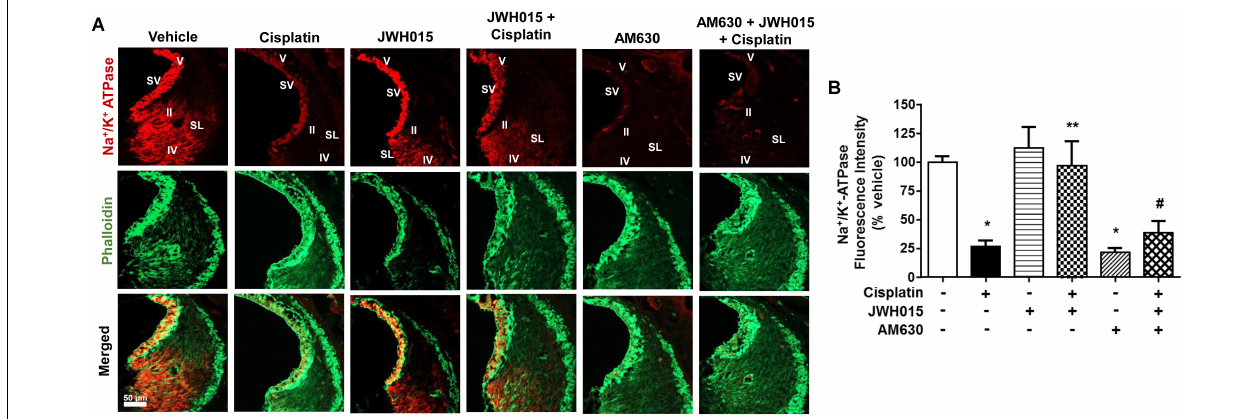
FIGURE 6 | Activation of CB2R by JWH015 mitigates cisplatin-induced loss of Na + /K + -ATPase- α 1 levels in the rat cochlea. (A) Mid-modiolar sections of the rat cochlea were co-immunolabeled with Na + /K + -ATPase- α 1 and phalloidin. The sections were imaged using Zeiss LSM800 scanning confocal microscope. Representative images from the base of the cochlea are shown ( n ≥ 3). (B) Bar graph represents % Na + /K + -ATPase fluorescence intensity ± SEM. Cisplatin decreases expression of Na + /K + -ATPase- α 1 in stria vascularis (SV) and spiral ligament (SL) and this is attenuated by pre-treatment with JWH015. AM630 added alone also reduced Na + /K + -ATPase immunoreactivity which was similar to cisplatin. ∗ p < 0.05 vs. vehicle; ∗∗ p < 0.05 vs. cisplatin; and # p < 0.05 vs. JWH015 + cisplatin (one-way ANOVA).